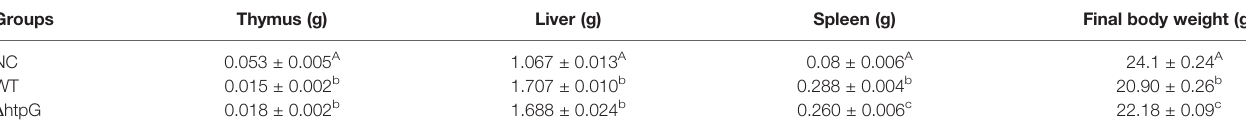
TABLE 2 | The organ weight and body weight of the mice challenged with S. Typhimurium.